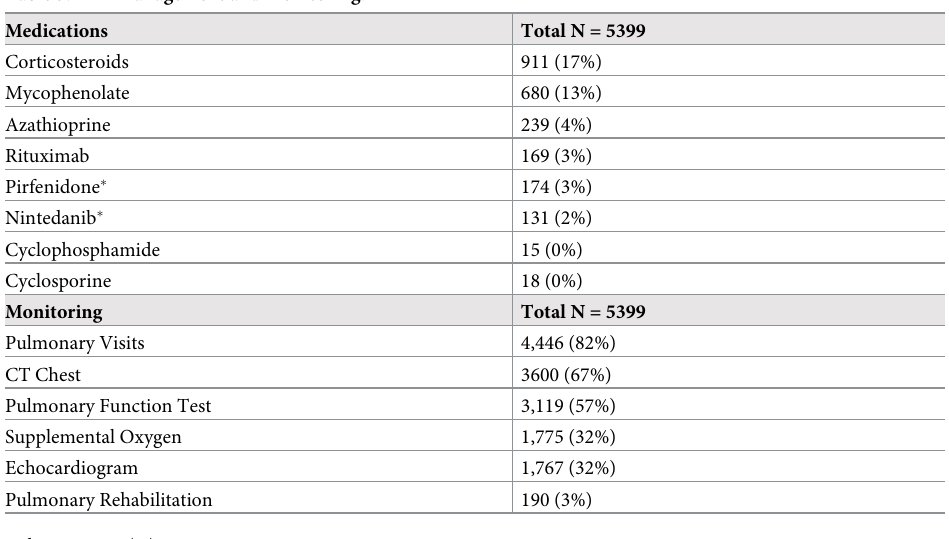
Table 3. ILD management and monitoring.